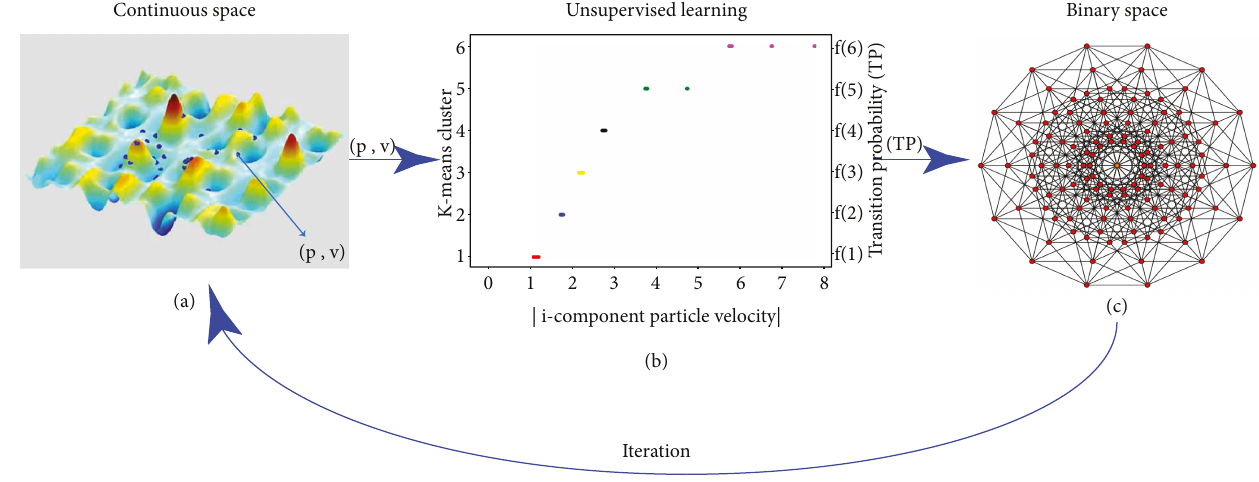
Figure 1: K-means binarization